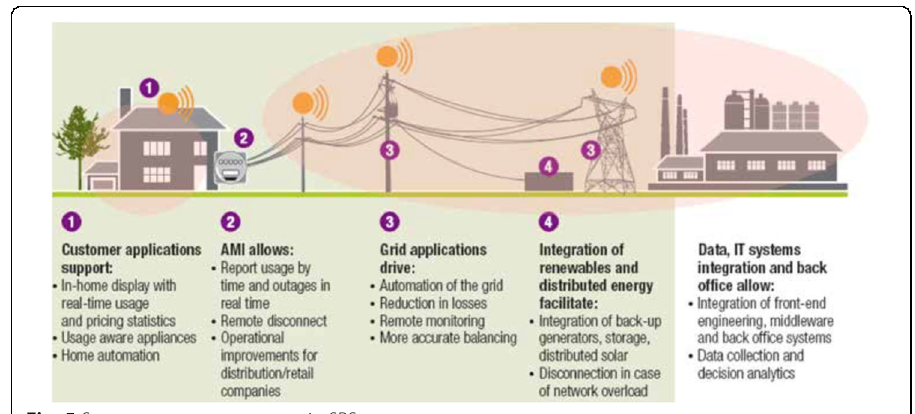
Fig. 5 Smart energy management in